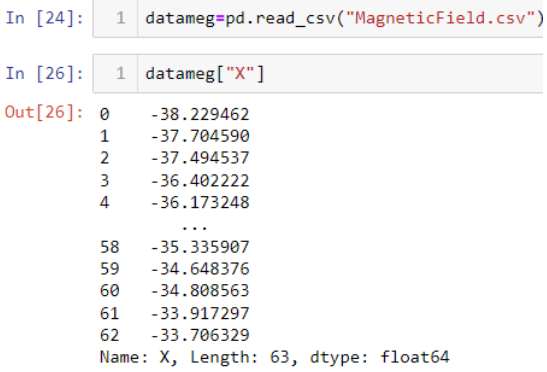
Figure 47. Magnetic x -axis data for point_1.